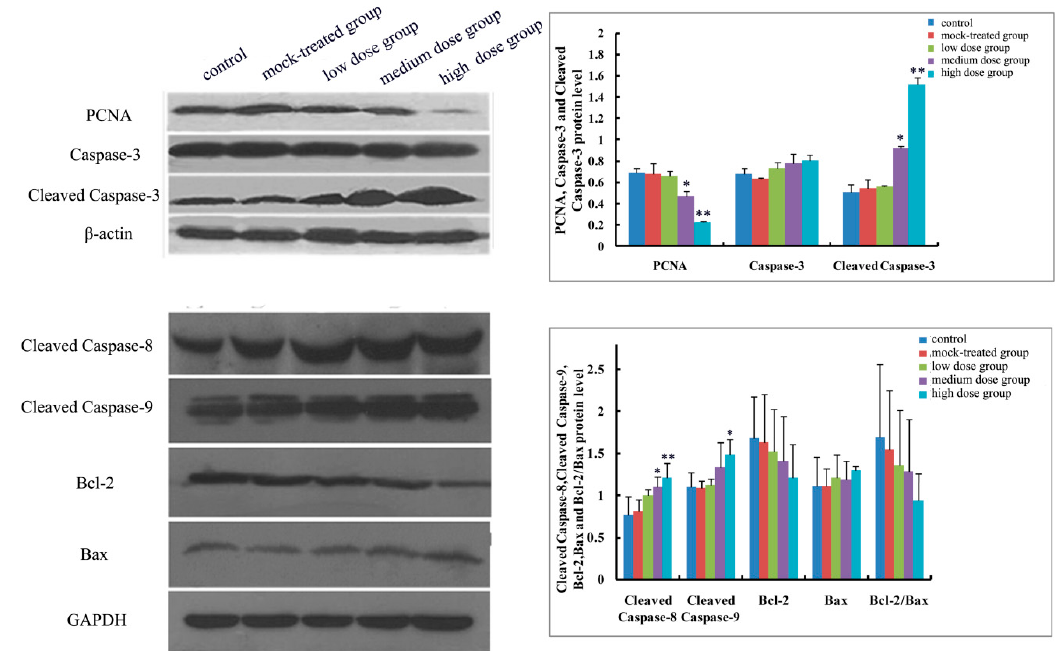
Figure 5. Expressions of apoptosis-related proteins (Caspase-3, Cleaved Caspase-3, Cleaved Caspase-8, Cleaved Caspase-9, Bcl-2, Bax, and Bcl-2/Bax) and proliferating cell nuclear antigen (PCNA) in cerebral cortex of mice offspring on postnatal day 1 after maternal exposure to PM 2.5 during pregnancy. Left: the results of Western blot; Right: histogram of relative protein levels. * p < 0.05, compared with control; ** p < 0.01, compared with control.